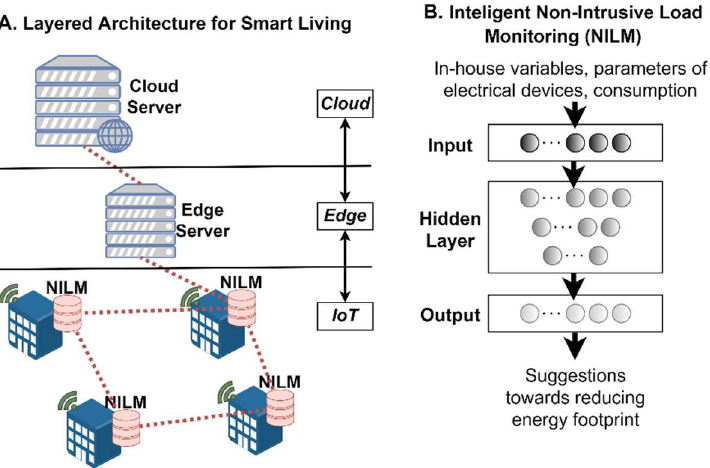
Figure 6. The interconnection of NILM ML model and data sharing in the RAMOS framework, targeting to provide suggestions towards energy footprint reduction at households.